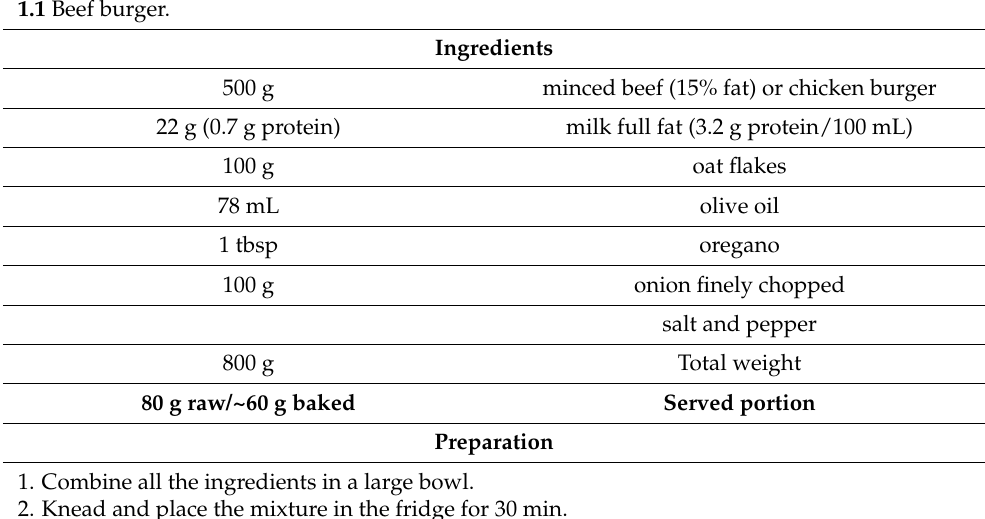
Table 1. Recipes for the Mediterranean milk ladder. 1.1 Beef